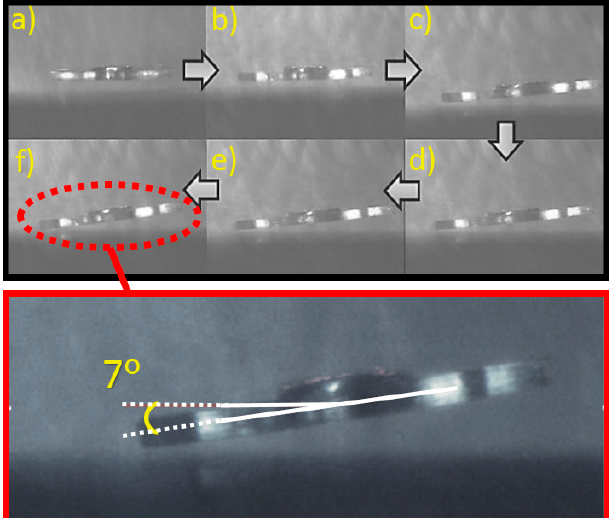
Figure 16. The cause of the head-tilt reaction is to suspend the directional changes of the vector field forces acting on the micro-UFO. The head-tilt angle is a parameter proportional to the phase difference. The increase in phase difference also causes an increase in head-tilt angle. As can be seen in the figure, in the experimental studies performed, the head-tilt angle of 7° is displayed. The increase on gradual tilting of the microrobot can be seen in the figure from ( a ) to ( f ).